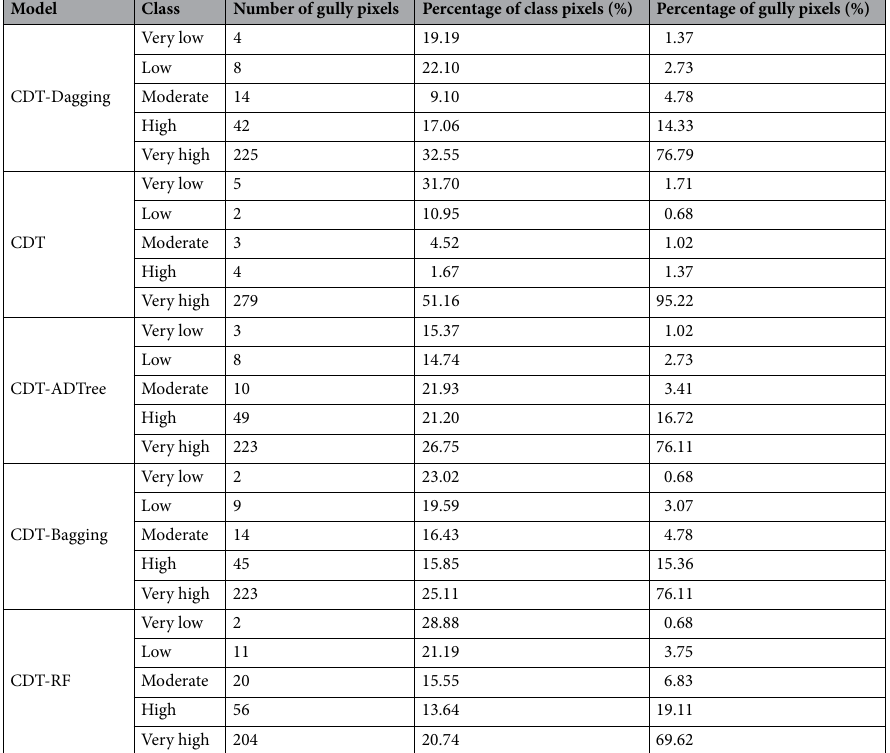
Table 4. Quantitative analysis of gully erosion susceptibility